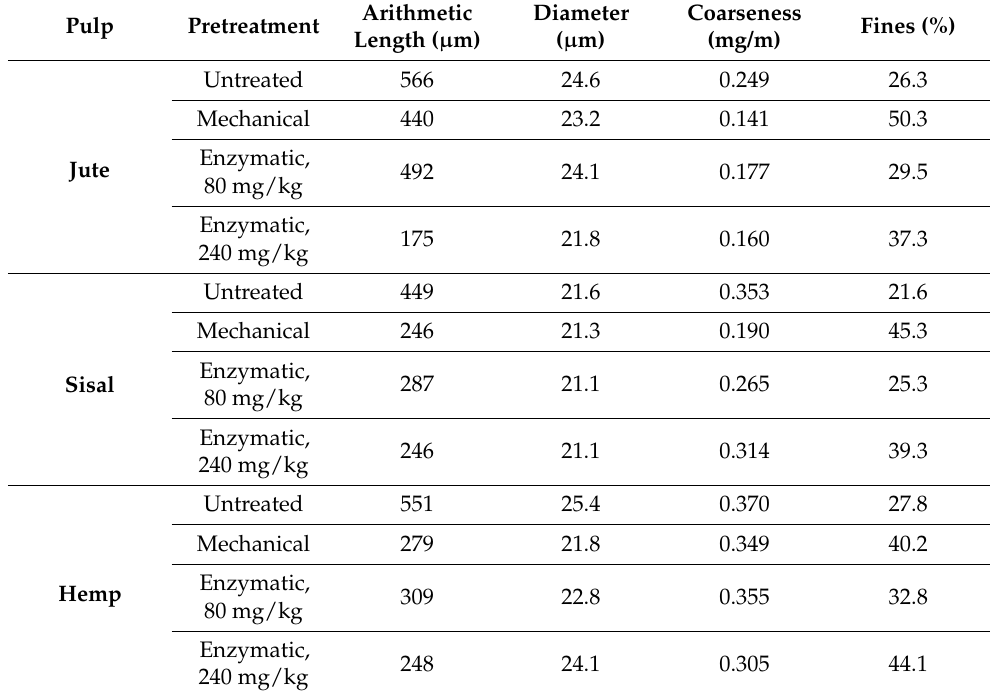
Table 1. Effects of mechanical and enzymatic pretreatments on key parameters of fiber morphology.